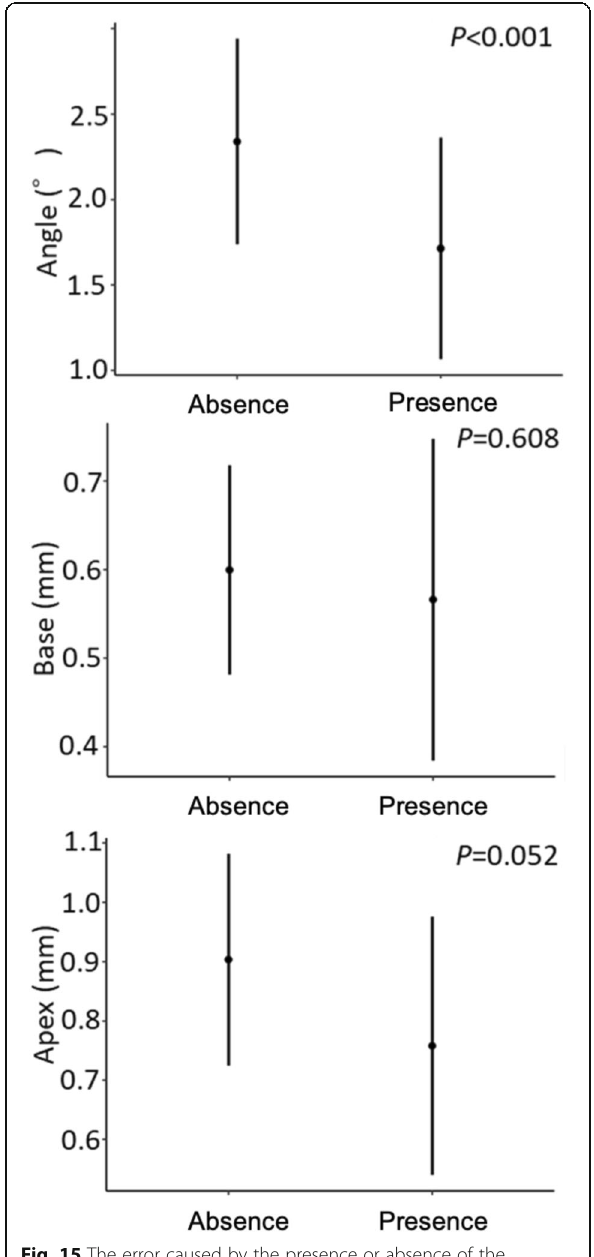
Fig. 15 The error caused by the presence or absence of the reinforcement structure. Error bars indicate 95% confidence